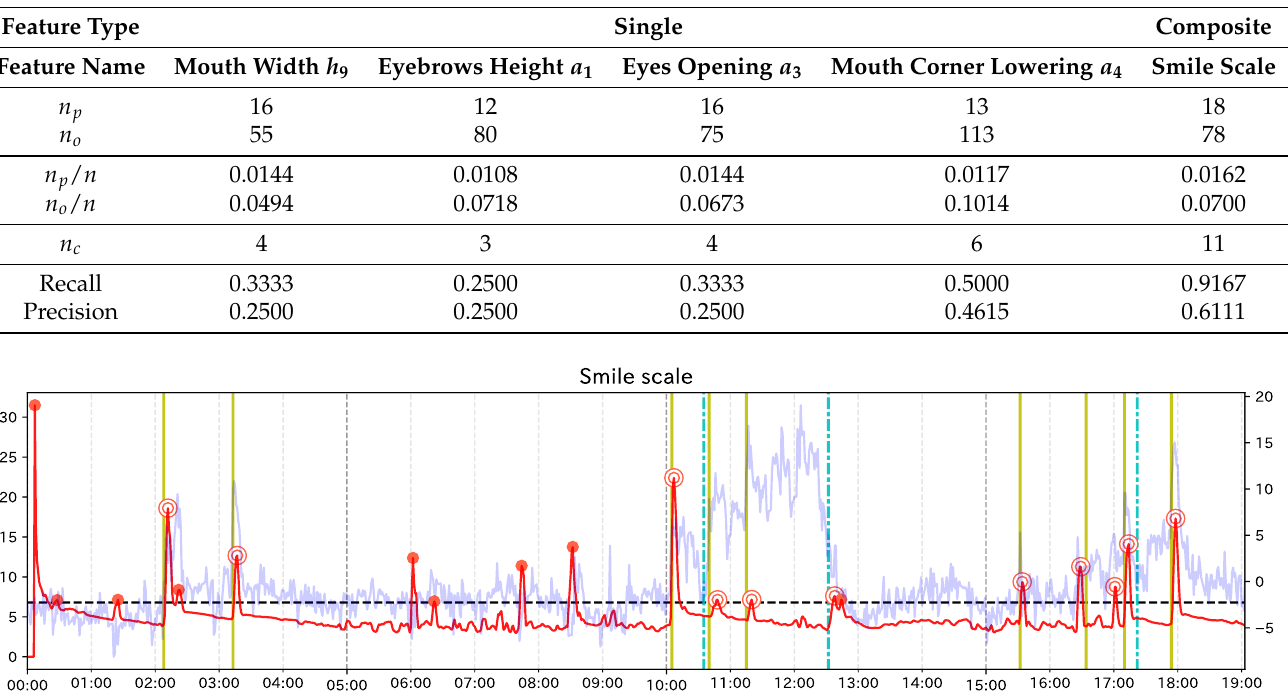
Figure 7. The graph showing the change score for Smile scale (test